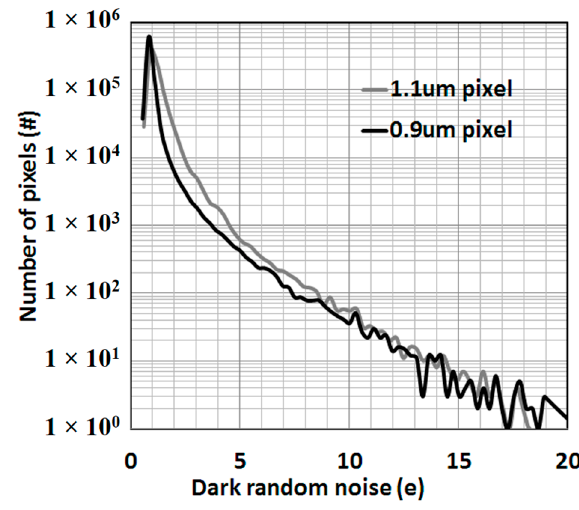
Figure 5. Statistical read noise distributions of the 0.9 µm pixel and the 1.1 µm pixel at an analog gain of 18 dB.